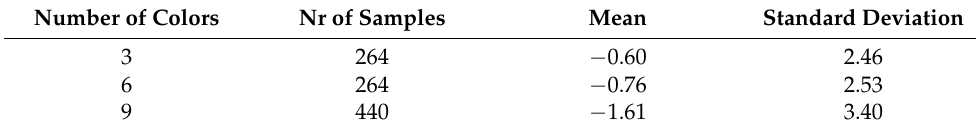
Table 5. Descriptive statistics of the error for the number of colors.